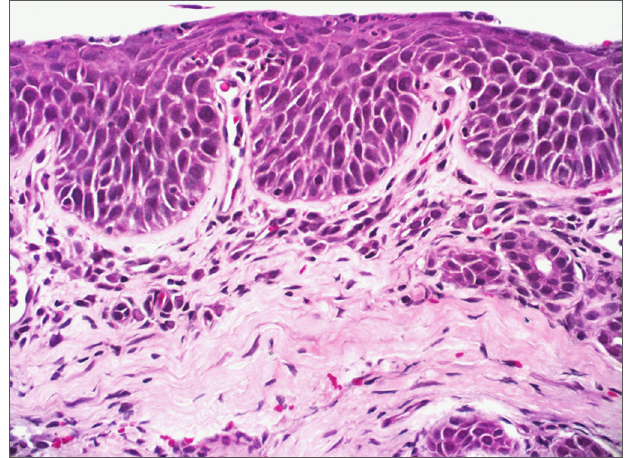
Figura 3. Rinite crônica moderada - lâmina com aumento de 400x